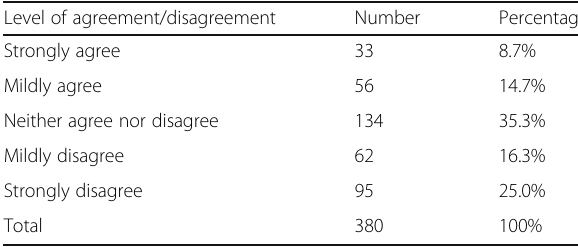
Table 4 Meat consumption negatively impacts on the ecological health of the planet: 2018 Sydney